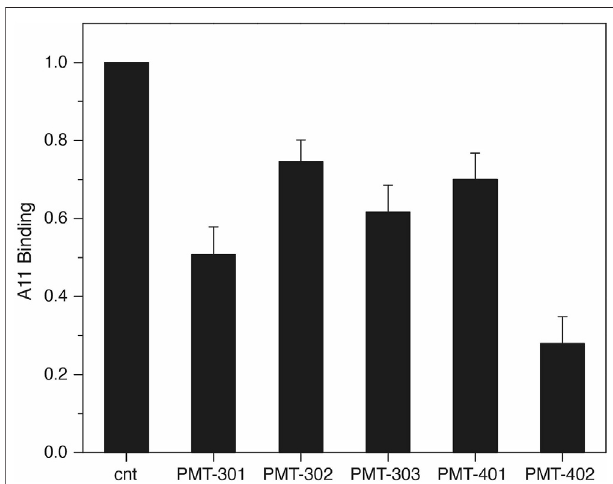
FIGURE 3 | Decrease in A11 antibody recognition of A β O following PAL treatment. the A11 antibody. Shown is the oxidized luminol signal (normalized to the untreated control) as reported by the HRP-secondary antibody. Quadruplicate samples were measured in each assay. Results are the average of three independent assays with error reported as